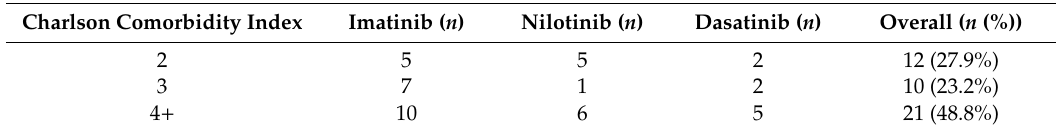
Table 3. Charlson Comorbidity Index of